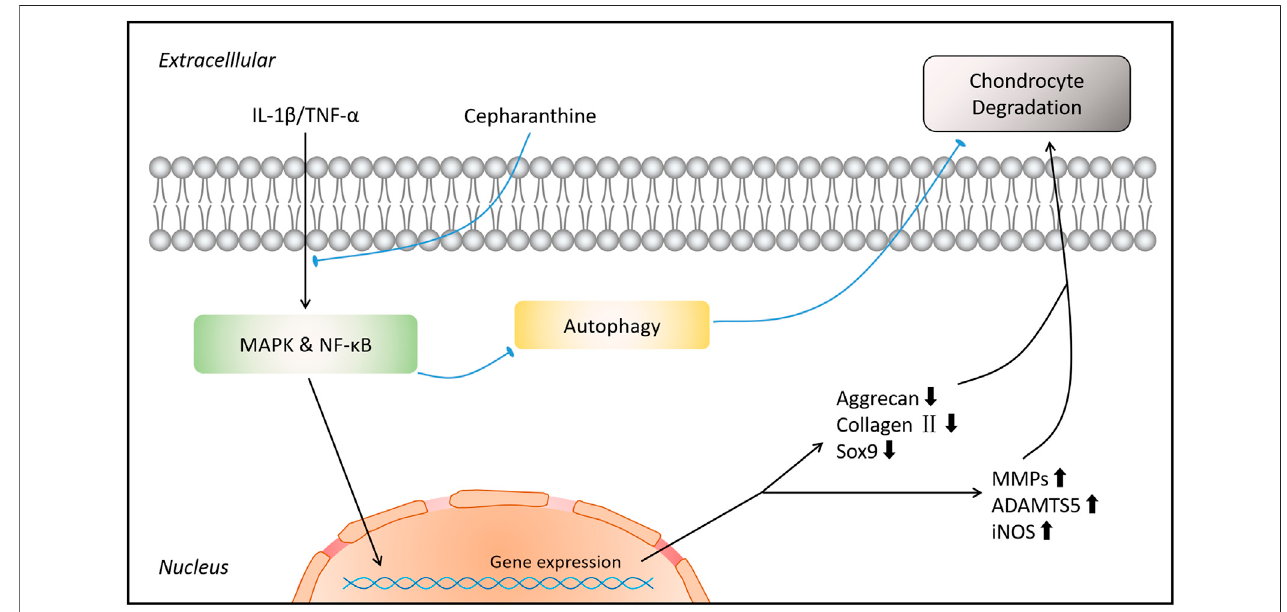
FIGURE 8 | Schematic diagram indicates the potential protective effect of CEP on osteoarthritis.